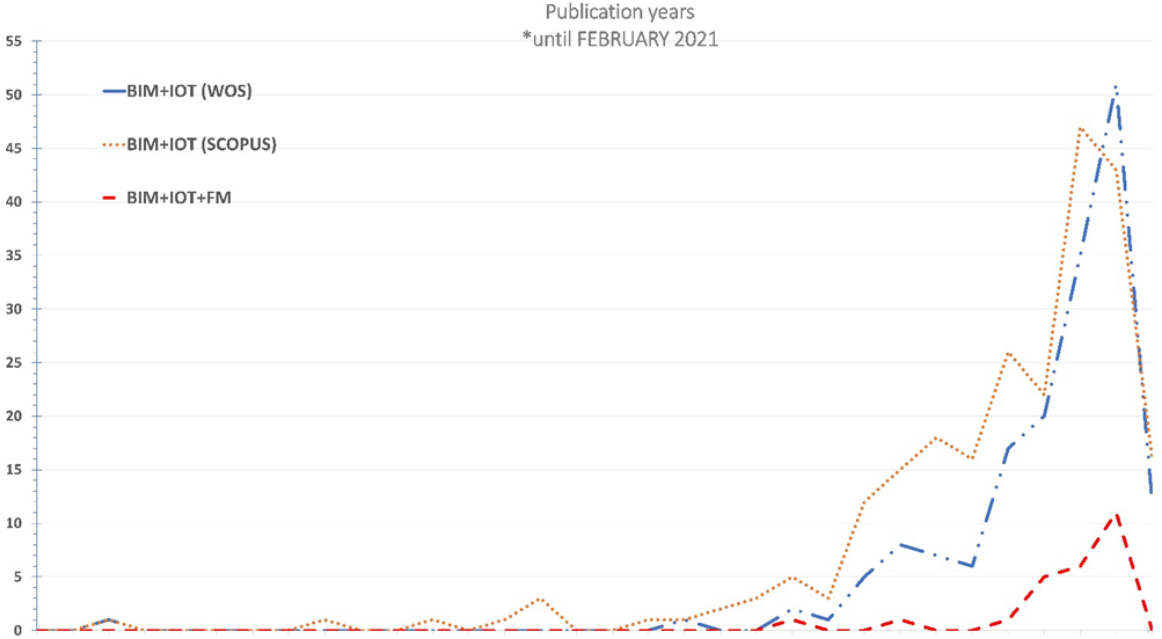
Figure 2. Number of publications per year (* until February 2021) dealing with BIM and IoT in Scopus (yellow dotted), in Web of Science (blue dash-dotted) and number of product dealing with BIM and IoT for Facility Management (red dashed).